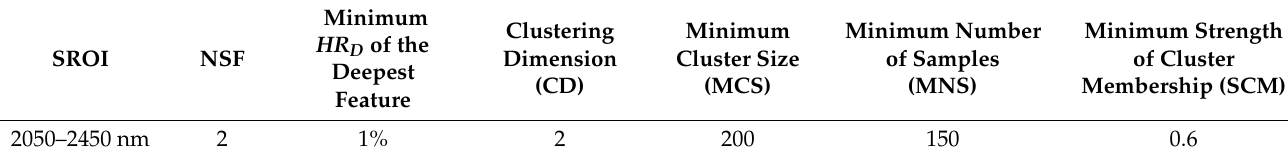
Table 2. The base level parameters used for feature extraction and clustering of the Mineral Systems Drilling Program (MSDP) spectral datasets.